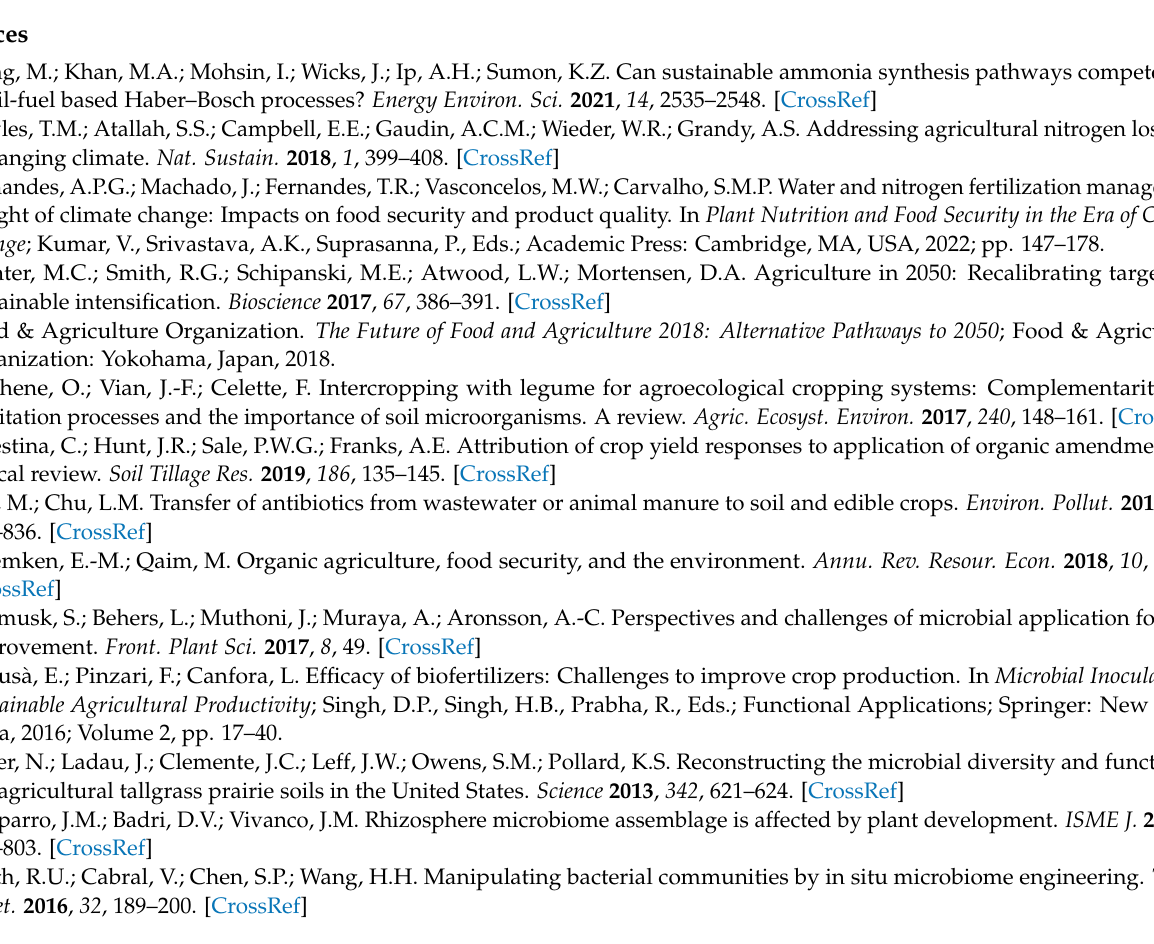
genus. Table S2. Soil main genus. Table S3. ASV-uniprot all matches. Table S4. Species UNIP. Table S5. Genus UNIP. Table S6. Enzymes and